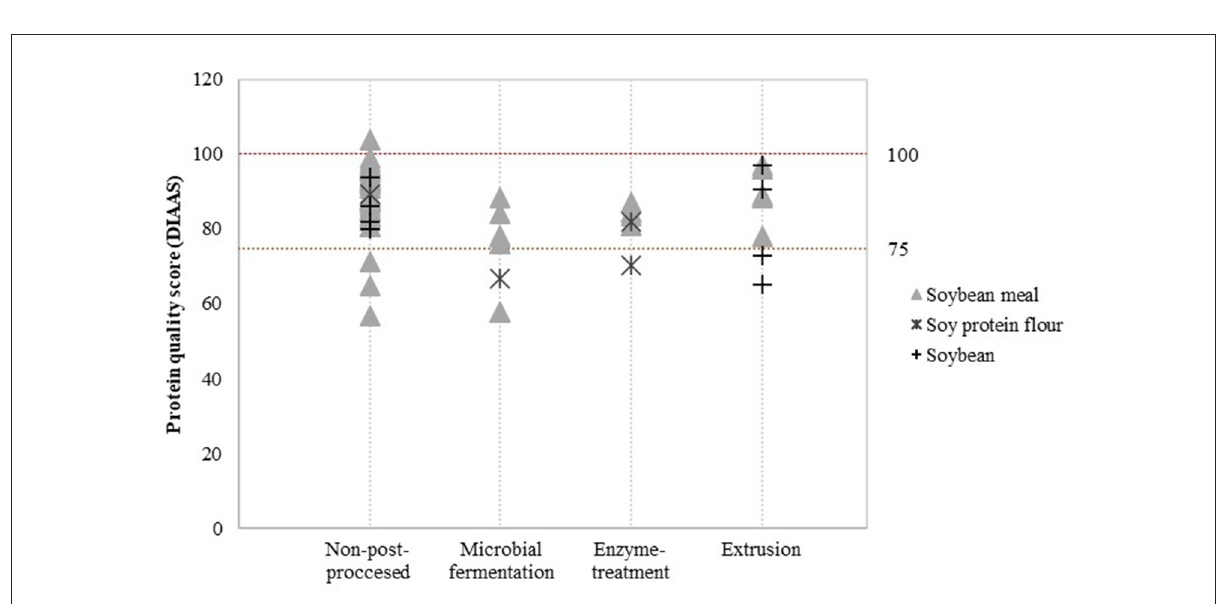
FIGURE4 Reported DIAAS for non-post-processed soy products and various post-processed soy products. Values derived from (16–20,